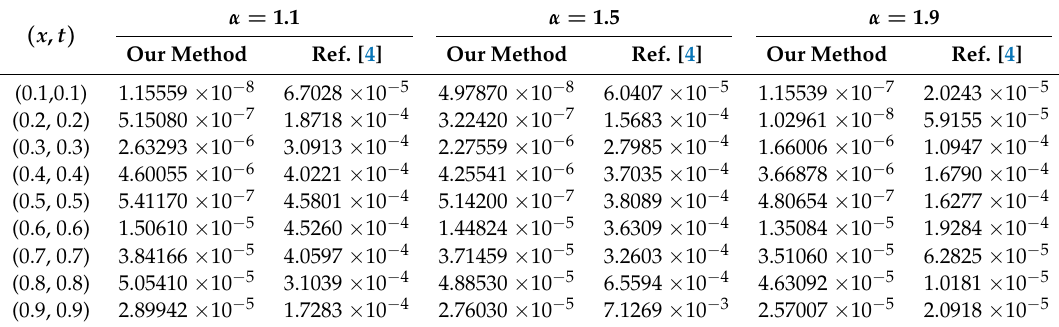
Table 2. Comparison of the absolute errors with [4] of Problem 1 for different values of α and M = 3.